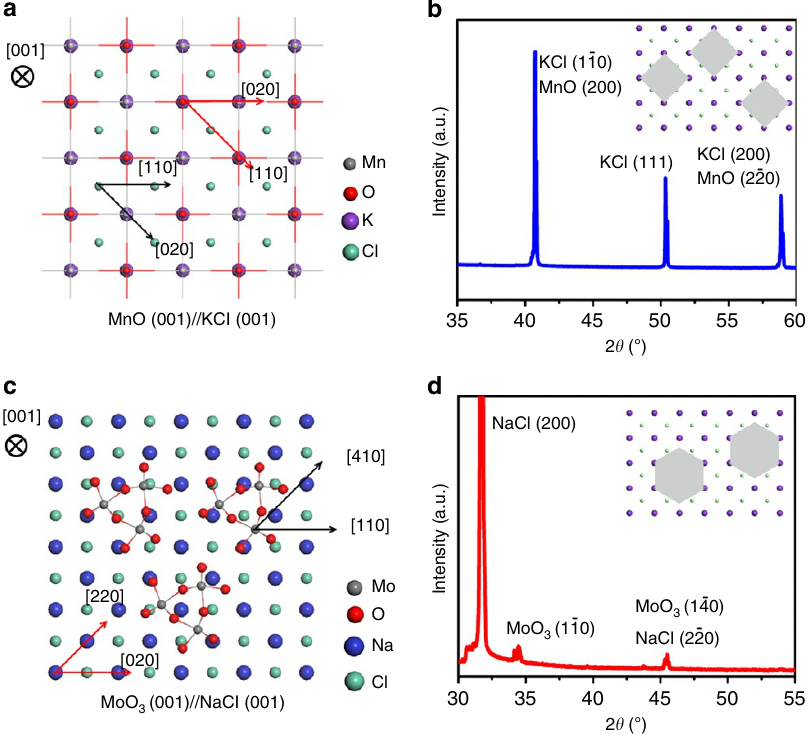
Figure 3 | Proposed mechanism of the salt-assisted templated growth of 2D MnO and h -MoO 3 . ( a ) Top view of the crystal modes of the MnO (001) plane sitting on the KCl (001) plane. ( b ) X-ray diffraction pattern of 2D MnO on KCl. Please note that the faint diffraction peaks of MnO reside at the left side of KCl diffraction peaks. The inset is a schematic representation of cubic MnO on KCl. ( c ) Top view of the crystal modes of the h -MoO 3 (001) plane sitting on the NaCl (001) plane. ( d ) X-ray diffraction pattern of 2D h -MoO 3 on NaCl. The inset is a schematic representation of h -MoO 3 on